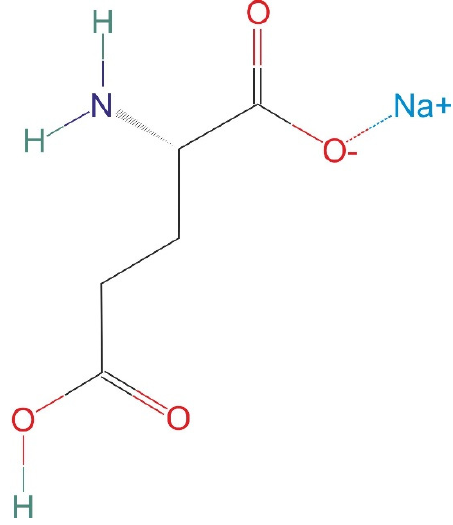
Figure 1. Chemical structure of monosodium glutamate .